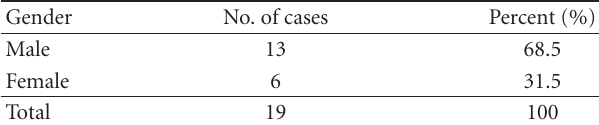
Table 1: Gender distribution.